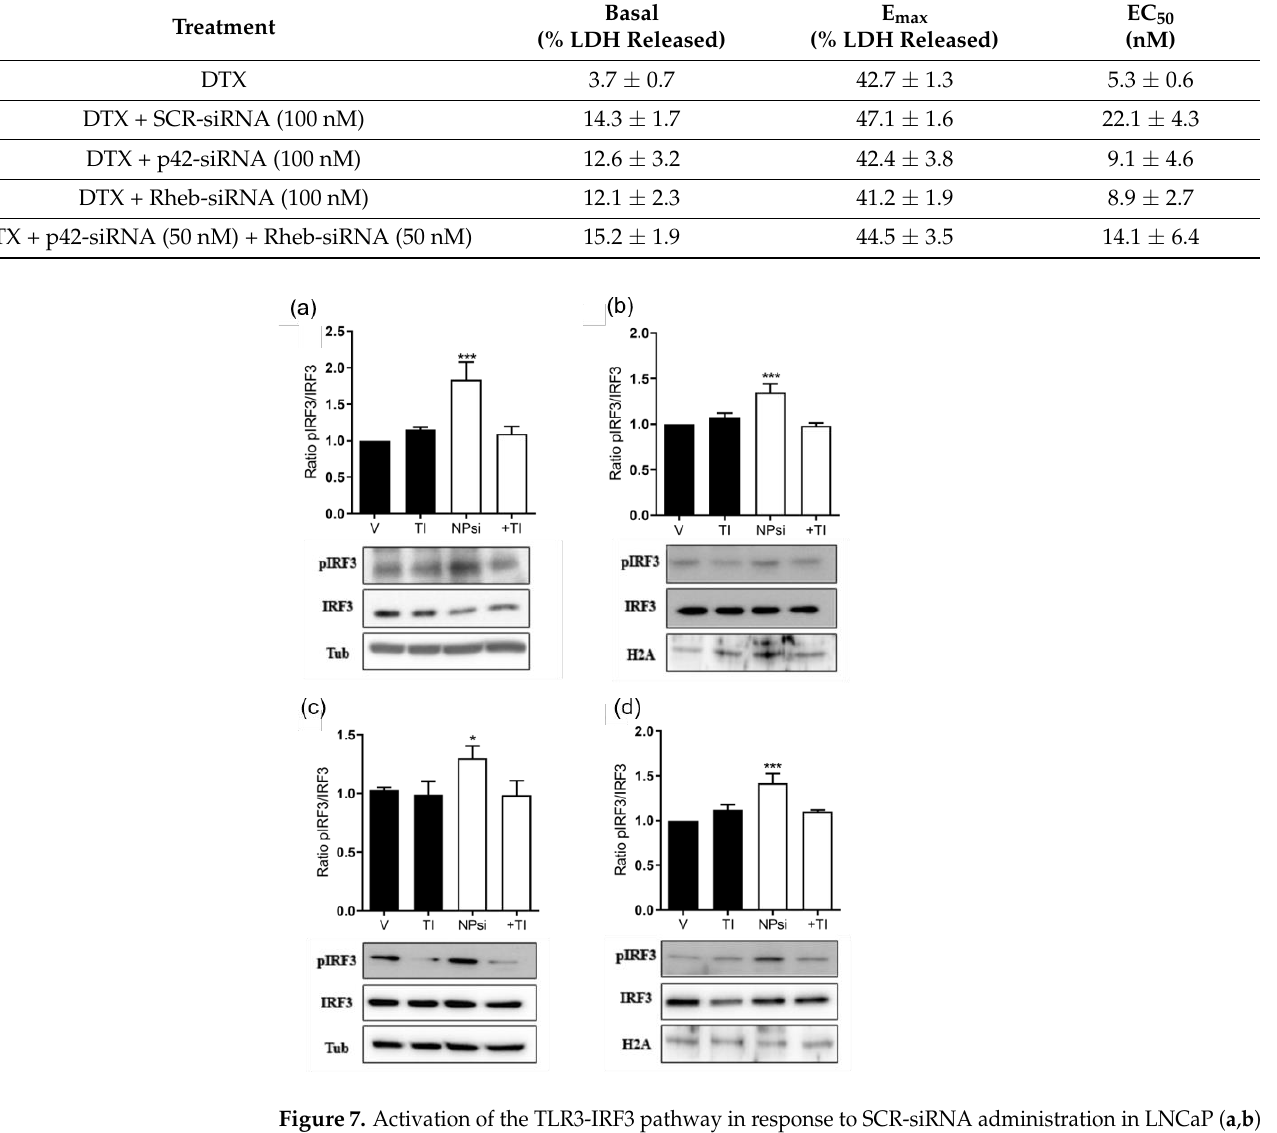
Figure 7. Activation of the TLR3-IRF3 pathway in response to SCR-siRNA administration in LNCaP ( a , b ) and PC3 ( c , d ) cells. Effect of the TLR3 inhibitor (R)-2-(3-chloro-6-fluorobenzo[b]thiophene-2-carboxamido)-3-phenylpropanoic acid (TI; 10 µM) on phosphorylation of IRF3 (pIRF3) induced by treatment of LnCaP and PC3 cells with nanocomplexes formulated from AMC11 (1 µM) + SCR-siRNA (100 nM) (Npsi) in both cytosolic ( a , c ) and nuclear ( b , d ) cellular fractions. Data are expressed as mean ± SEM from 6 to 12 determinations from at least 3 independent